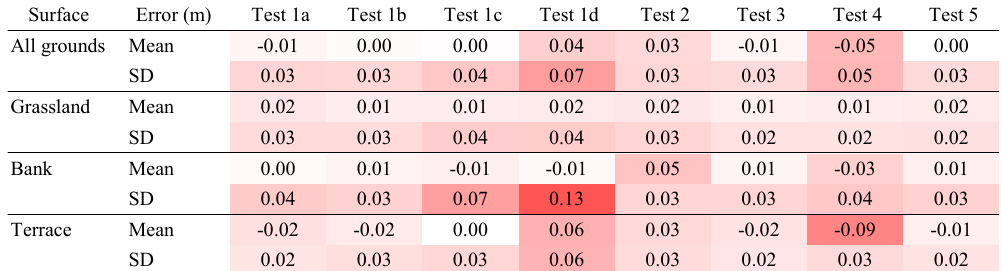
Figure 5. Elevation error distributions for SfM tests 1a, 1b, 1c, and 1d, assuming that the RTK points are correct and without error. Indicated overlaps are the minimum. Table 2. Mean and standard deviation of elevation differences between SfM DSMs and GPS points. Colour intensity indicates the deviation from zero value with minimum/maximum of ± 0 . 13m.